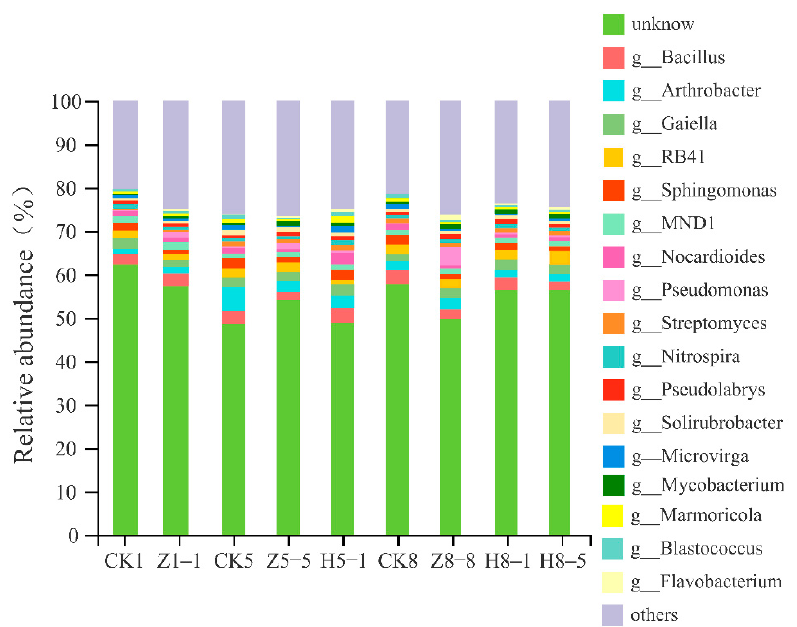
Figure 8. Community composition of bacteria at the genus level in soil in different years of growing and replanting. Note: The nomenclature of each sample is the same as that in Table 2. At the species level, 90.87% of all samples were unknown. Except for the unknown